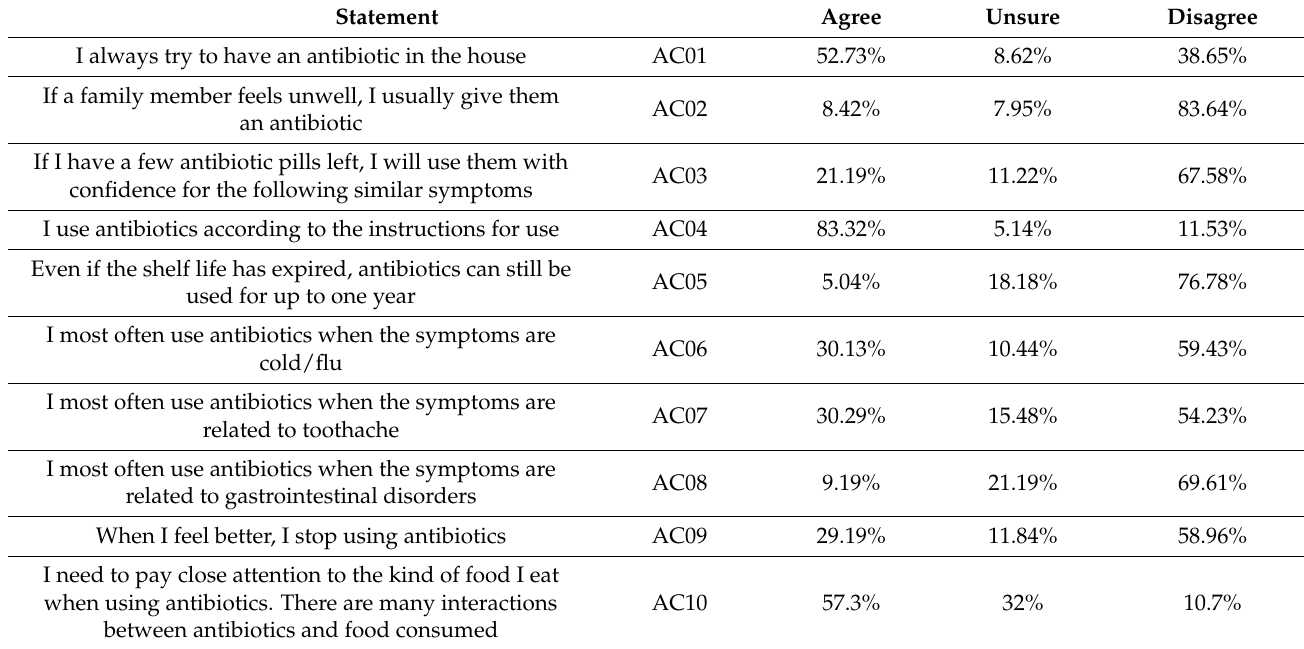
Table 4. Respondents’ attitude towards antibiotics